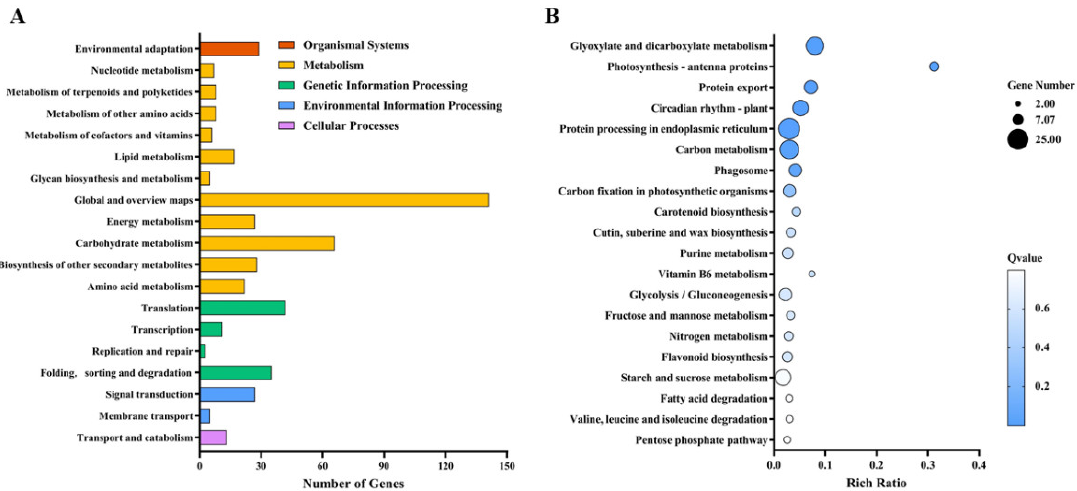
Figure 6. KEGG term comparison of differential genes with and without betaine soaking treatment under heat stress: ( A ) KEGG classification of differential genes; ( B ) bubble diagram of differential gene KEGG enrichment.